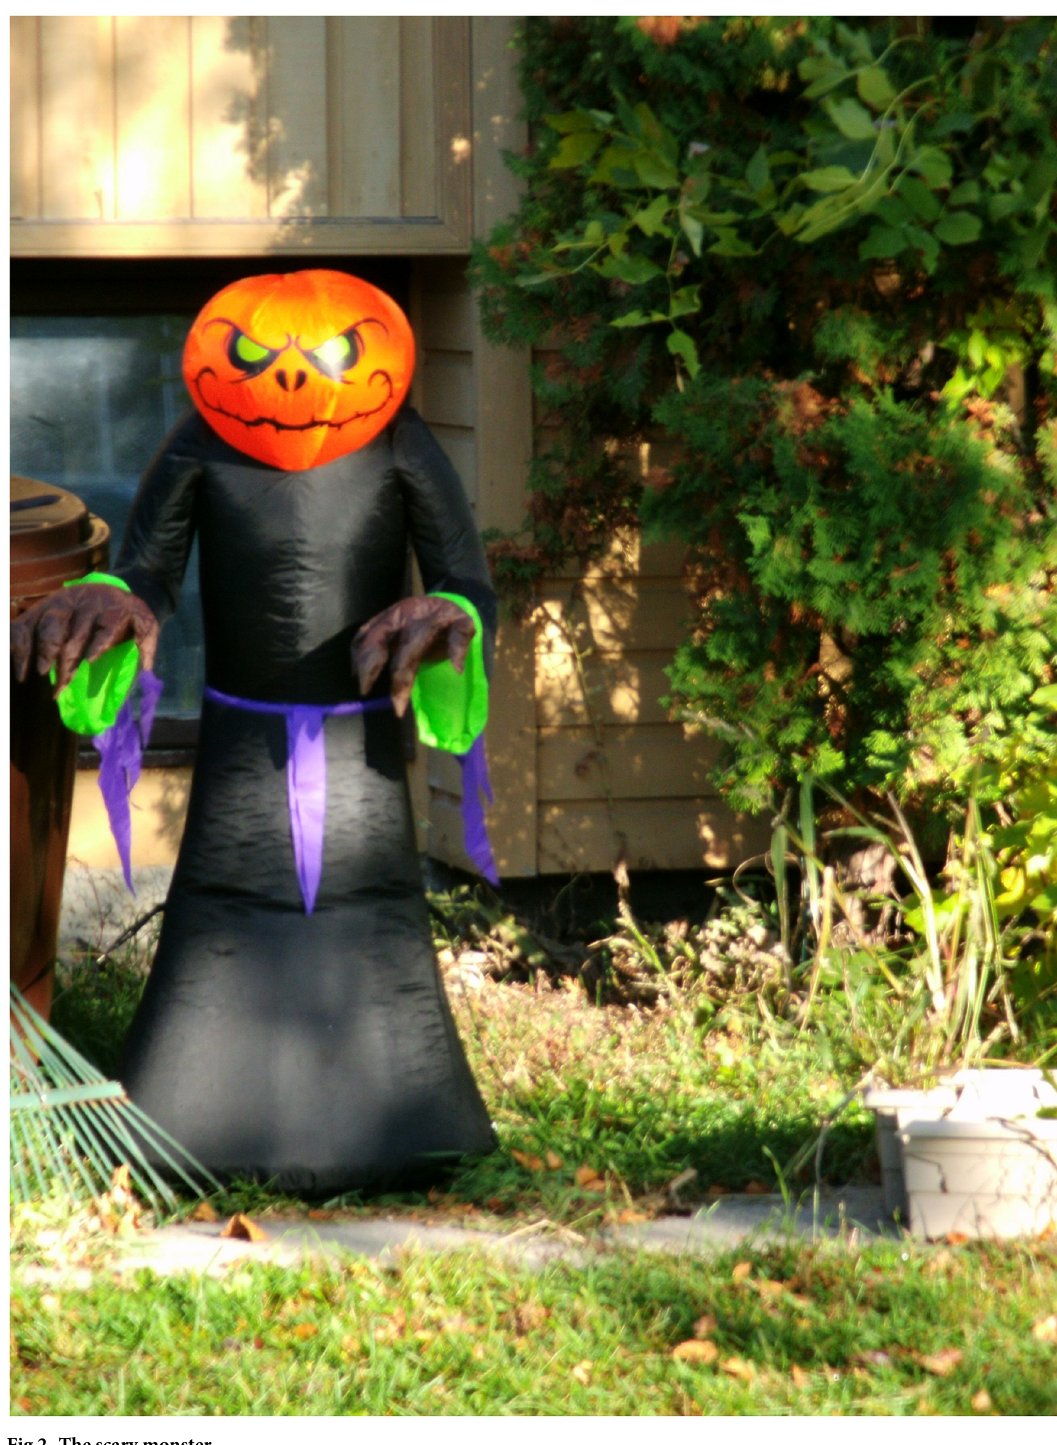
Fig 2. The scary monster.